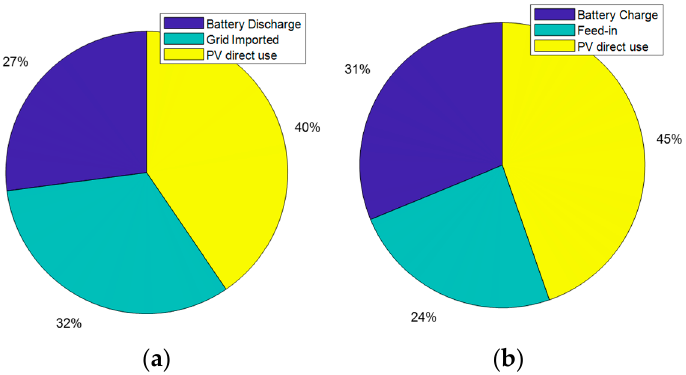
Figure 9. ( a ) Self-sufficiency rate. ( b ) Self-consumption rate.